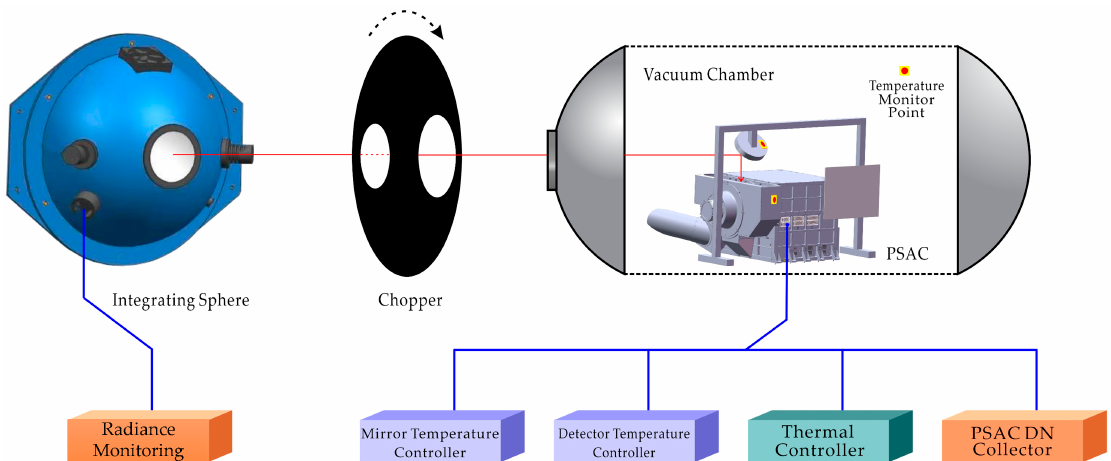
Figure 8. Schematic diagram of the instrument-level thermal vacuum sub-experiment. The PSAC was installed on the base plate of the vacuum chamber, and the fixed-point observation mode was used with a chopper to substitutability observe the integrating sphere and the dark reference. A turning light path was installed to ensure that the light source was incident to the PSAC. Temperature monitoring was performed for the PSAC body, the planar mirror, the vacuum chamber, and other key